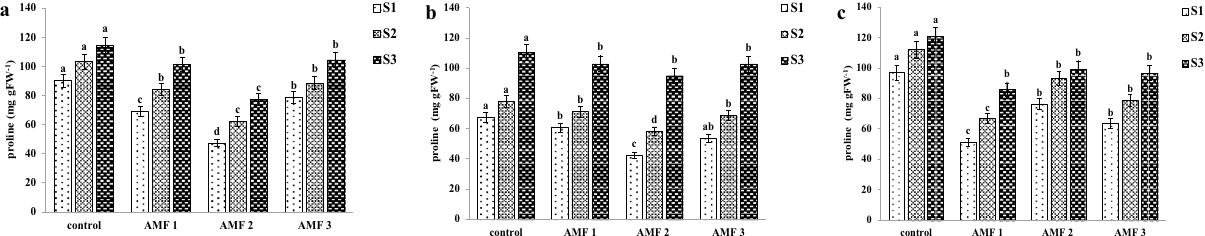
Figure 2. Effect of salinity level and AMF pre - inoculation on leaf proline concentration of eucalyptus clone H4 ( A ), H8 ( B ) and P6 ( C ) 90 days after planting. Mean values shown, in which the same letters above the bars represent no significant difference, according to HSD at P ≤ 0.05. Abbreviation : AMF1; Glomus sp.2, AMF2; G. albida , AMF3; G. decipiens , control, not pre-inoculated with AMF. S1; 10 dS m −1 , S2; 15 dS m −1 , S3; 20 dS m −1 . Variable Chlorophyll